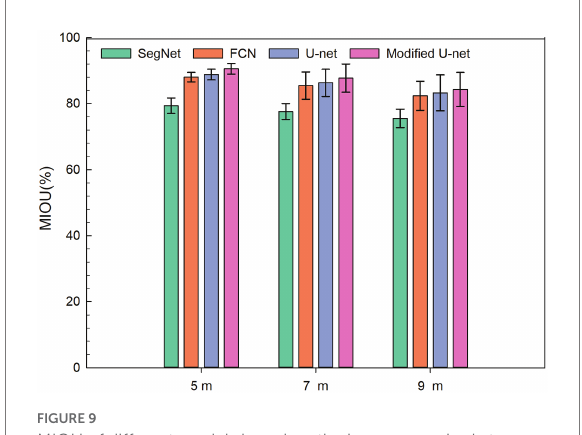
FIGURE 9 MIOU of different models based on the images acquired at different